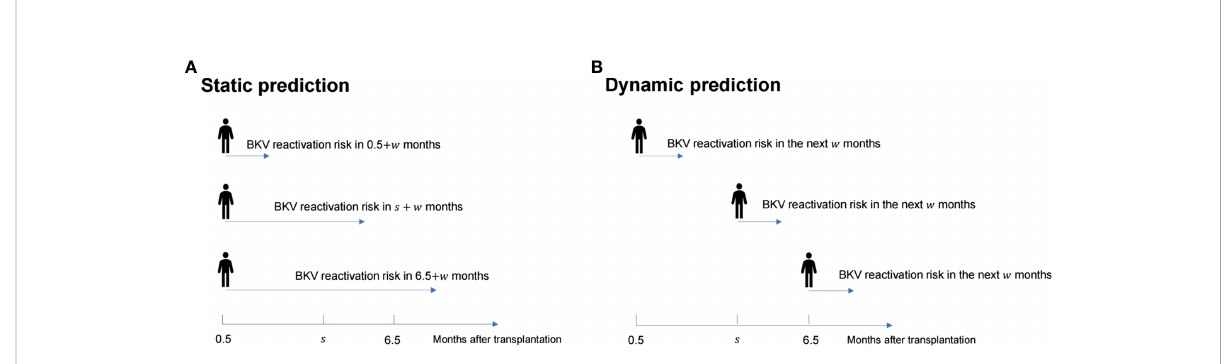
FIGURE 1 Schematic diagram of the difference between the static prediction (A) and dynamic prediction (B)